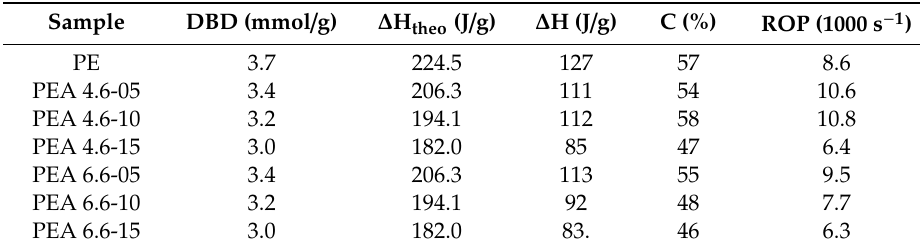
Figure 6. Photo-DSC of the PEAs: Conversion ( a ) and rate of polymerization ( b ). Table 3. Double-bond density (DBD), theoretical and experimental enthalpy of curing, conversion, and maximum rate of polymerization (ROP) of the resins at 25 ◦